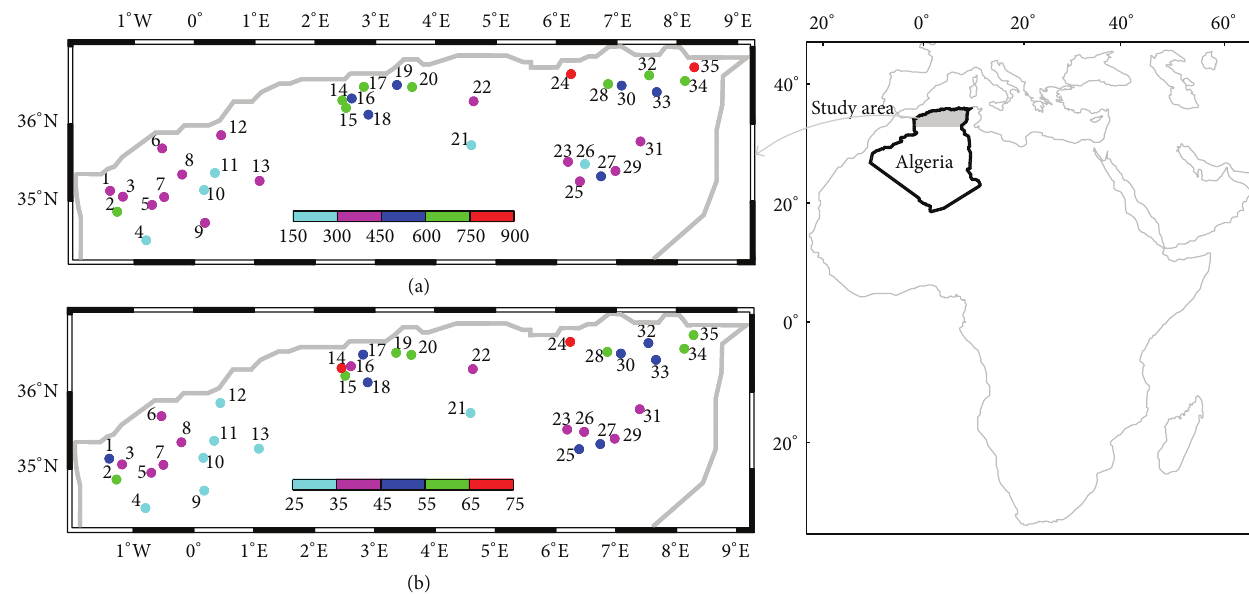
Figure 1: Locations of rainfall stations in northern Algeria and mean values intervals of annual rainfall (a) and annual maximum daily rainfall